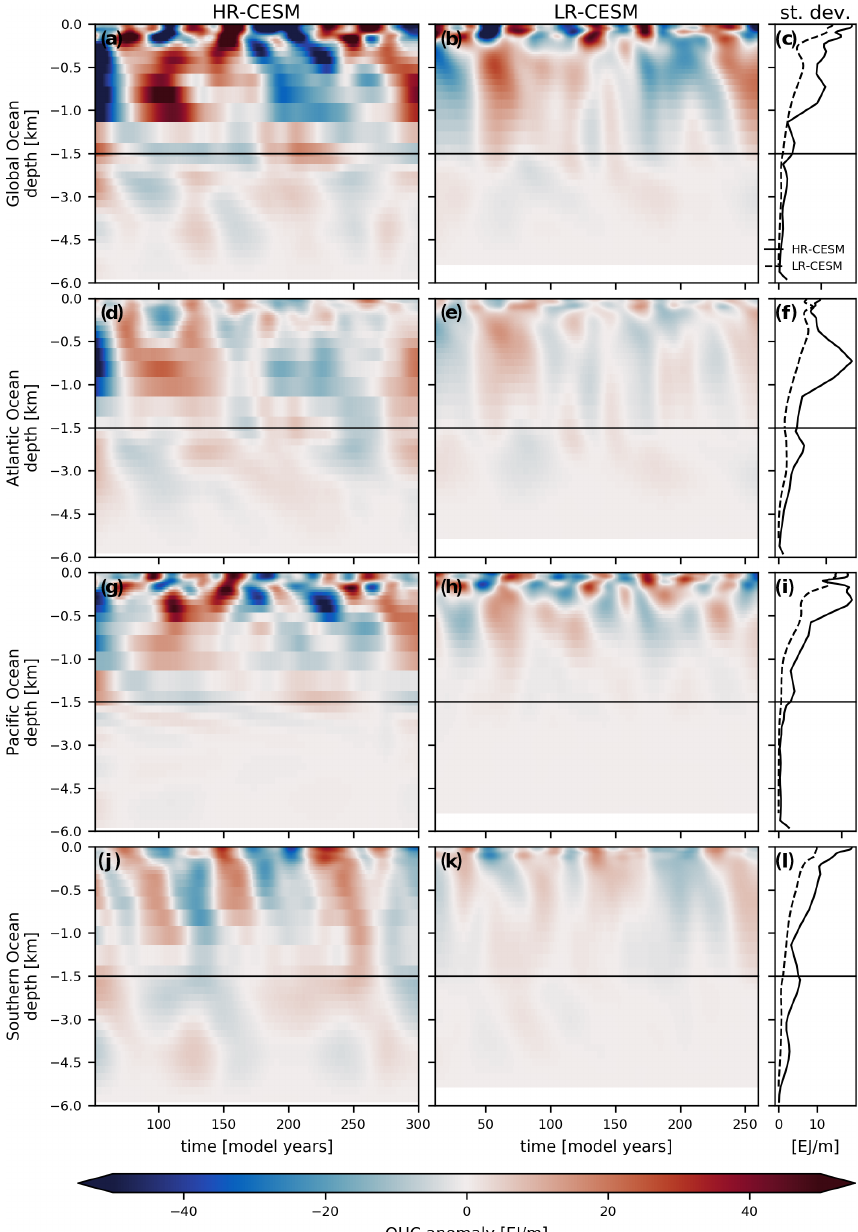
Figure 7. The 13-year low-pass-filtered horizontally integrated OHC anomalies (OHC h (t,y) of Eq. 6) as Hovmöller diagrams of the HR- (left) and LR-CESM (center) simulations, respectively. The different rows show the global, Atlantic, Pacific, and Southern Ocean integrals over time. Note the change in depth scale at 1500m. The right column shows the standard deviation in time of horizontally integrated OHC (solid: HR-CESM; dashed: LR-CESM), calculated similarly as in Fig. 6. Units are in EJm − 1 = 10 18 Jm − 1